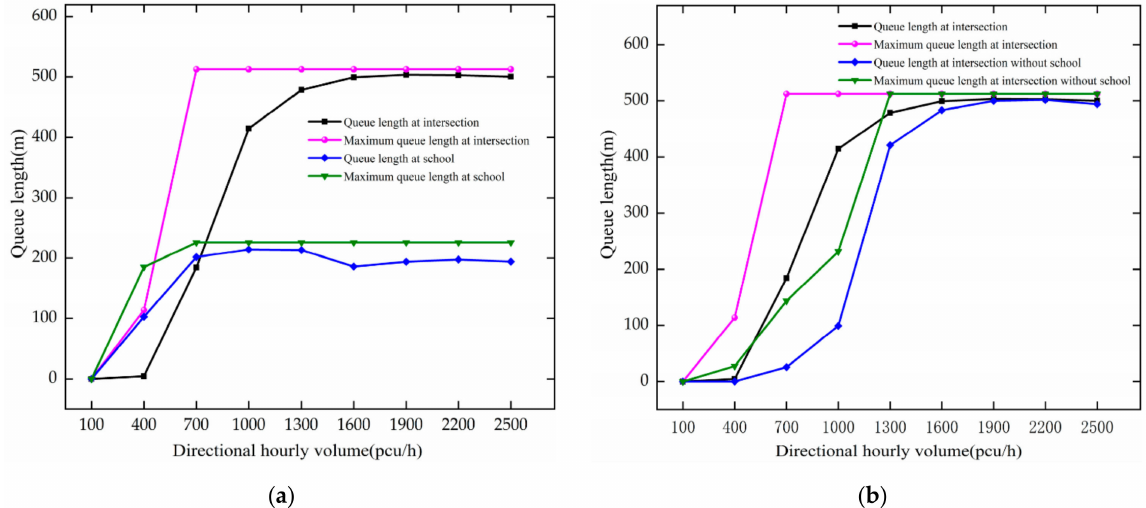
Figure 6. Variation trend of queue length with DHV. ( a ) queue length of the intersection and the school. ( b ) comparison of queue length at the